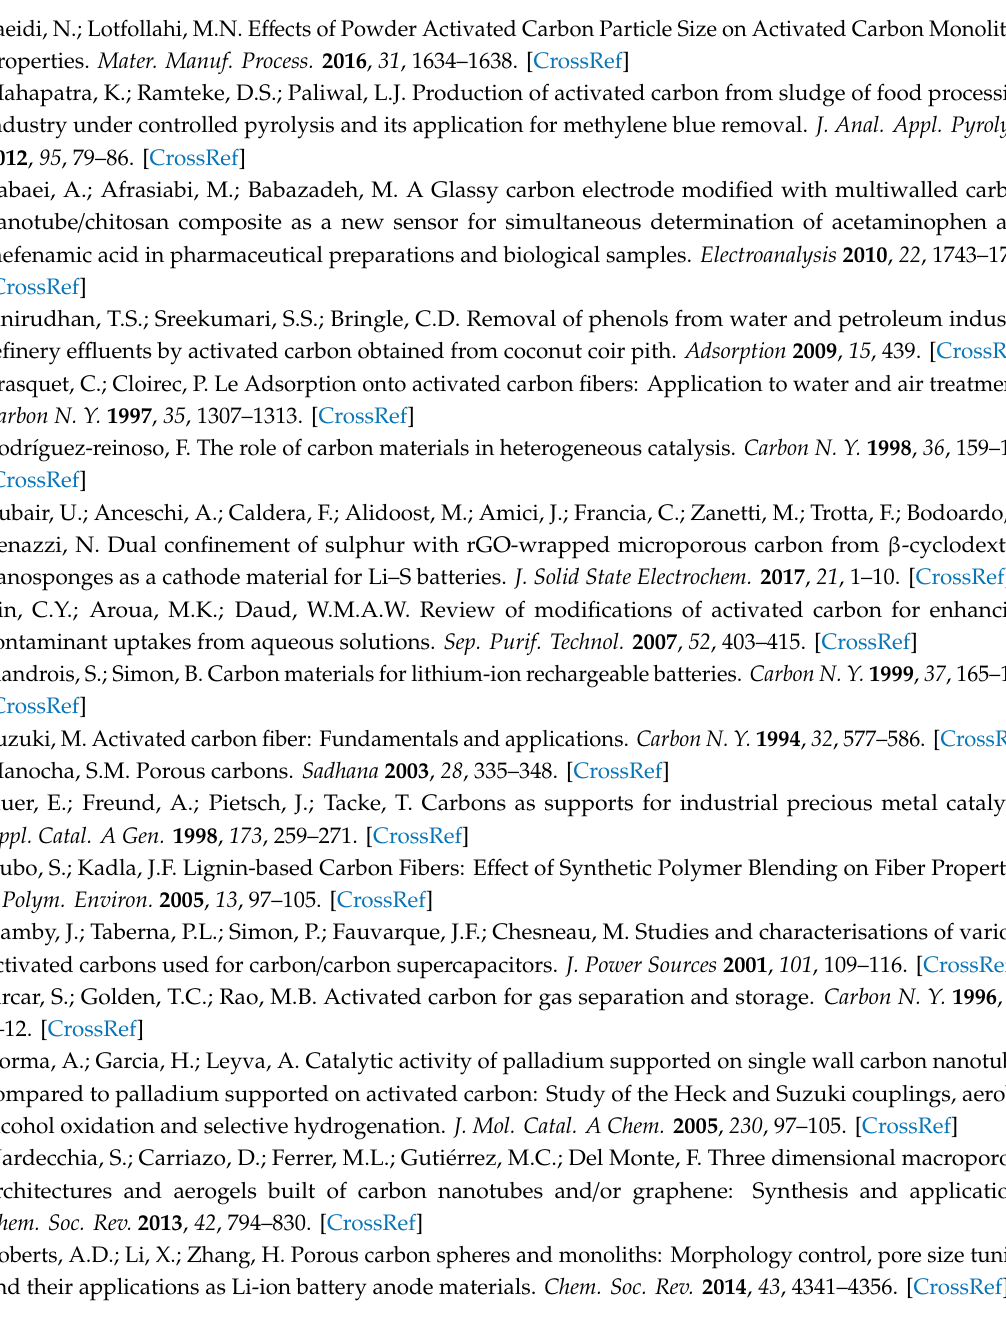
Supplementary Materials: The following are available online, Figure S1: FT-IR Spectra of β NS monolith before and after 18 and 27 h of extraction, Figure S2: FT-IR Spectra of LcNS monolith before and after 18 and 27 h of extraction, Figure S3: a) carbon from a-CD-NS 100 × ; b) the inner part of a-CD-NS carbon 500 × ; c) carbon from g-CD-NS 100 × ; d) the inner part of g-CD-NS carbon 500 × , Figure S4: SEM image of the carbons form b-CD cross-linked with the pyromellitic dianhydride in molar ratio